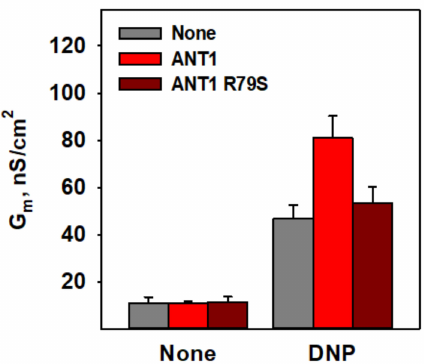
Figure 5. Effect of the ANT1 R79S mutation on DNP-mediated proton transport. Total specific membrane conductance (G m ) of the lipid bilayer membranes reconstituted with ANT1 (red) or ANT1 R79S (dark red) in the presence and absence of 50 µ M DNP. The experimental conditions were the same as in Figure